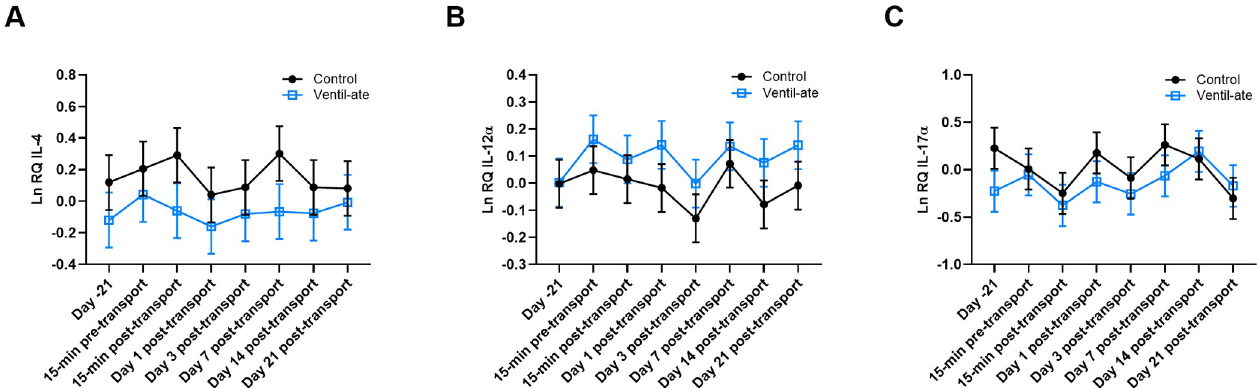
Fig 3. Whole blood gene expression of (A) IL-4, (B) IL-12 α with baseline (Day –21) values included as a covariate, and (C) IL-17 α with baseline (Day –21) values included as a covariate. Relative quantities (RQ) are natural log (Ln) transformed. For illustrative purposes, the figure displays the results (least squares means ± SE) from the analyses that included the group-by-time interaction. (A–C) No significant group, time, or group-by-time effects were observed. IL,